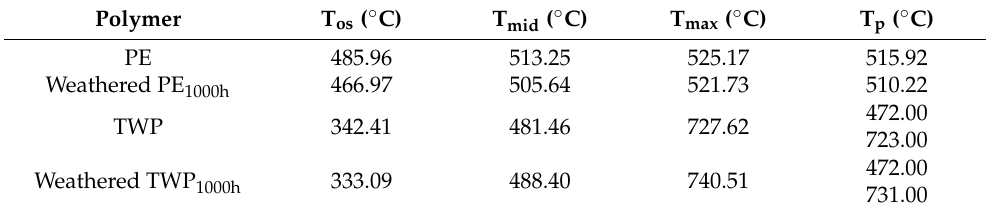
Table 1. Thermal profile determined for (i) PE (ii) weathered PE 1000h (iii) TWP (iv) weathered TWP 1000h .